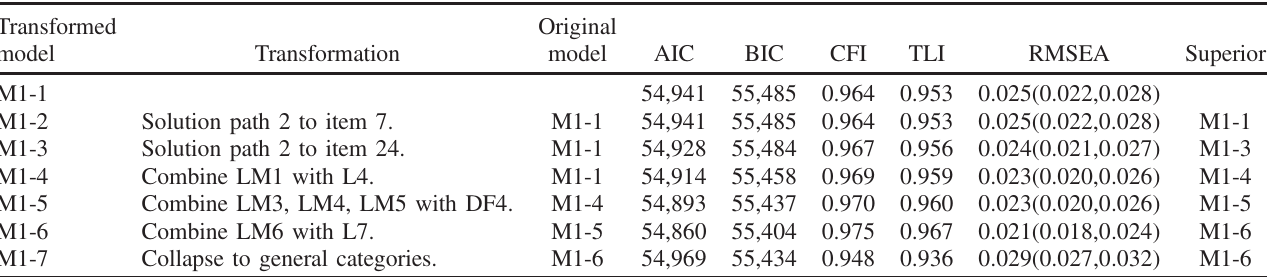
TABLE II. Sample 1 model transformation. Differences in AIC and BIC determine whether the models are statistically different; CFI, TLI, and RMSEA indicate the quality of fit for each model.